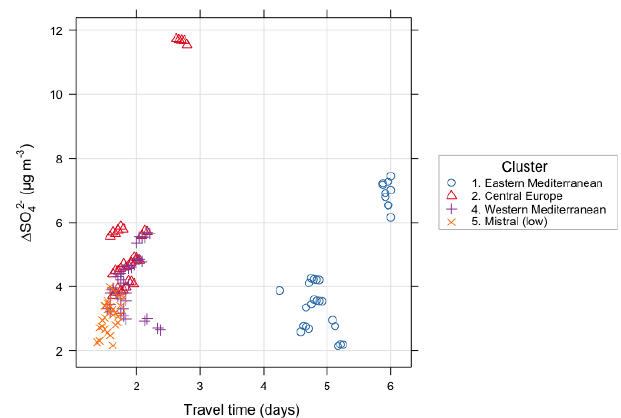
Figure 15. The difference in the PM 1 SO 2 − at Lampedusa and Ersa as a function of the travel time of the air masses from Ersa to Lampedusa. Colours represent the air-mass ori- gin